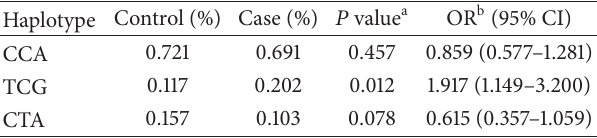
Table 4: Association of haplotypes in AGT gene with diabetes in the male